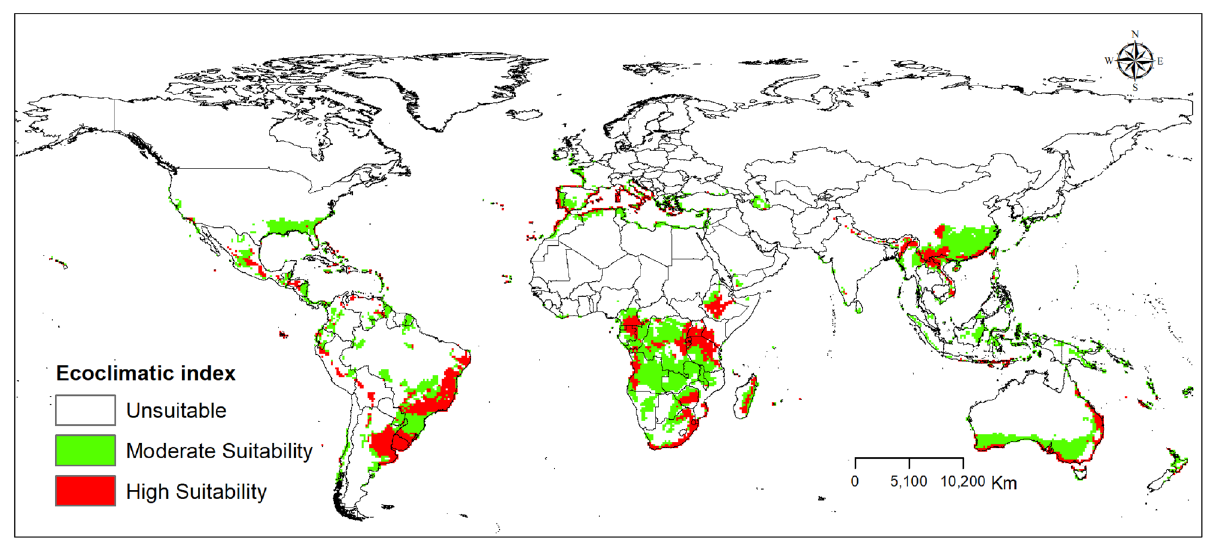
Figure 3. The Ecoclimatic Index (EI) for Trioza erytreae is modelled using CLIMEX for the current climate. ESRI ArcMap 10.2.2 (https:// suppo rt. esri. com/ en/ Produ cts/ Deskt op/ arcgis- deskt op/ arcmap/ 10-2- 2# downl oads) and Climex 4.0.0 (https:// www. hearne. softw are/ Softw are/ CLIMEX- DYMEX/ Editi